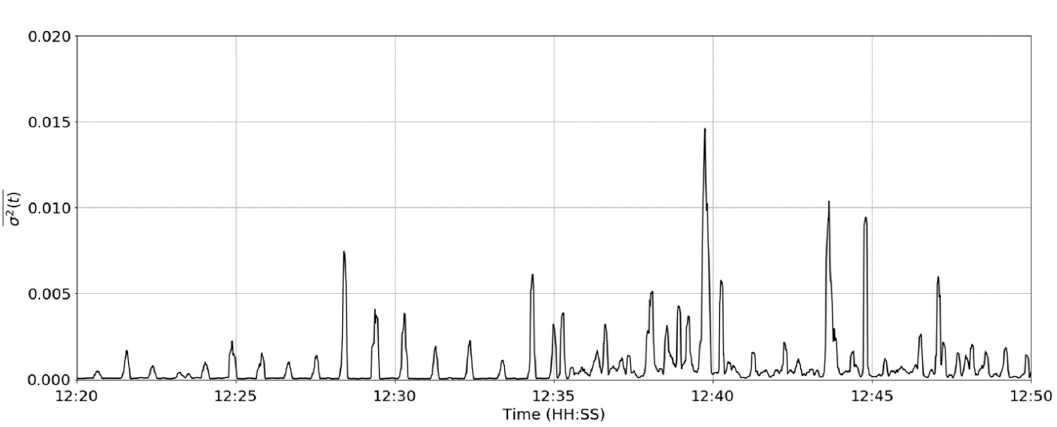
Figure 7. The mean of rolling variance over using an 8 s window.